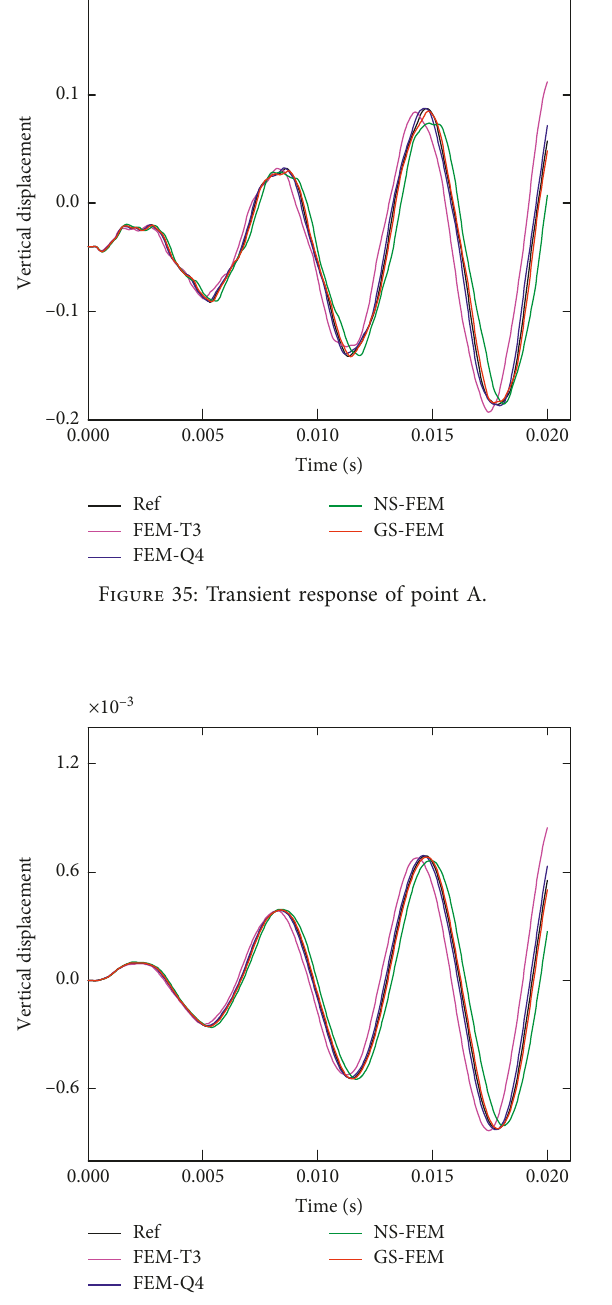
Figure 36: Transient response of point B.